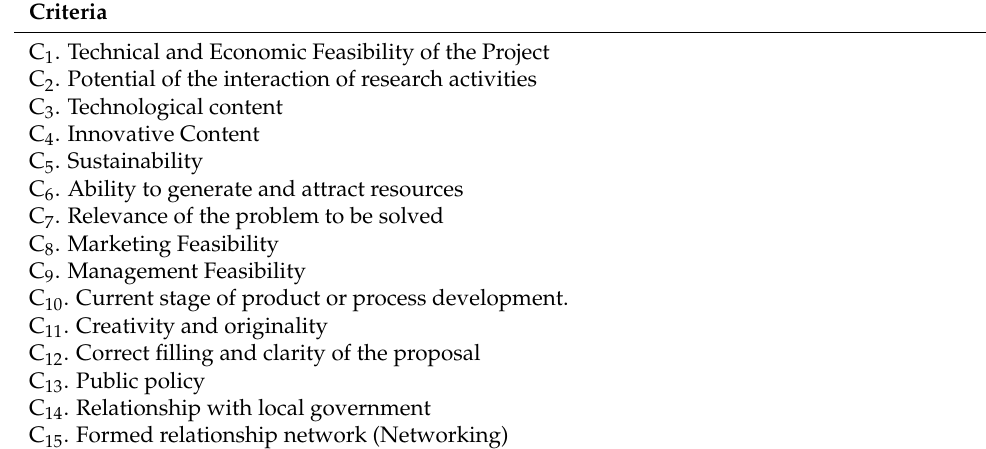
Table 11. Criteria for evaluation [43].